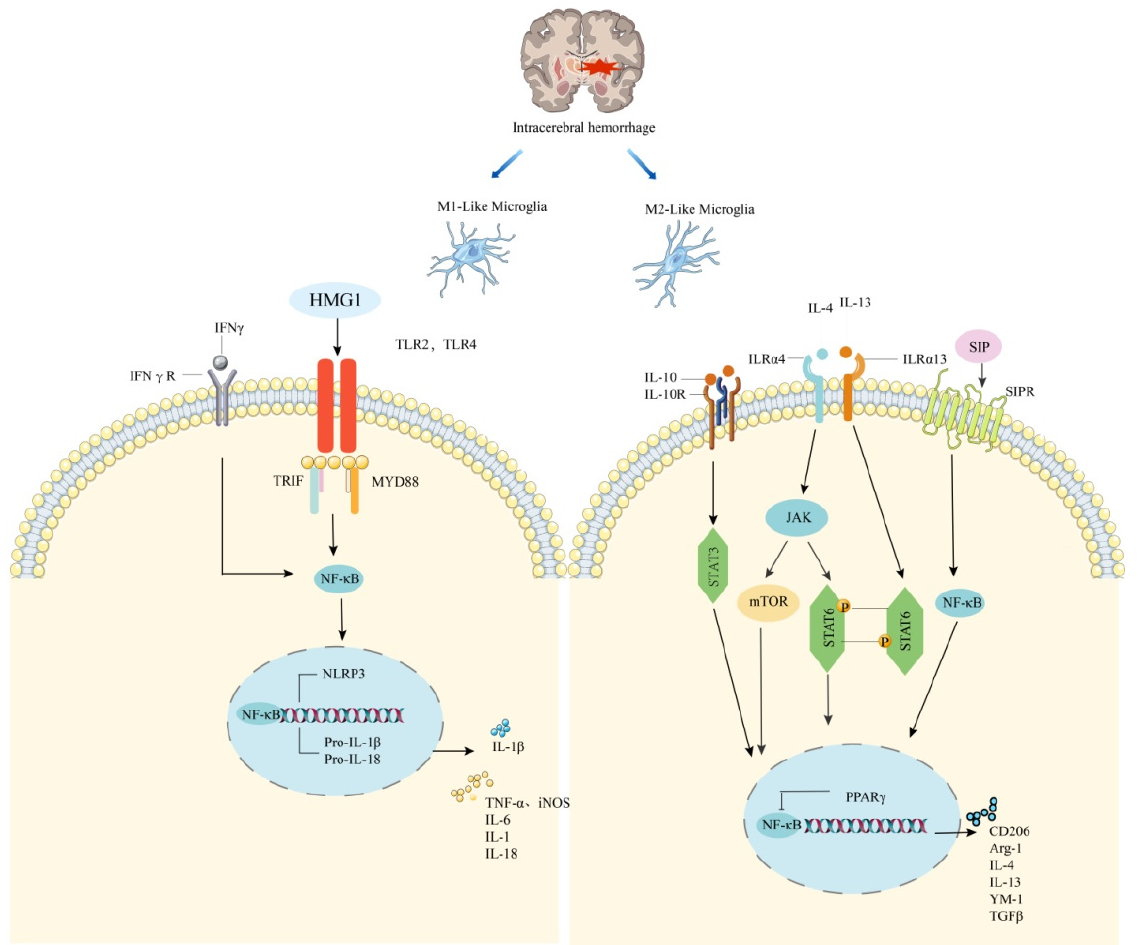
Figure 1. Mechanism of microglia polarization after cerebral hemorrhage. Activation of high-mobility histone 1 (HMG1) and Toll-like receptor (TLR)2 or TLR4 promotes M1-like responses in microglia via the NF- κ B pathway. Binding of IFN γ to the receptor promotes microglia polarization to the M1 state. STAT6 accumulates in response to IL-4 and is responsible for transcription of M2-associated genes. IL-13 and IL-4 upregulate the expression of M2 microglia markers, including Arg-1 and YM1, in microglia via the JAK-STAT6 pathway. IL-10 inhibits the production of anti-inflammatory factors. Sphingosine-1-phosphate (S1P) receptor signalling contributes to the downregulation of proinflammatory cytokines and enhances M2-like responses after ICH; MYD88, myeloid differentiation primary response protein MYD88; TRIF, TIR domain-containing adaptor molecule 1; PPAR γ , Peroxisome proliferator-activated receptor- γ